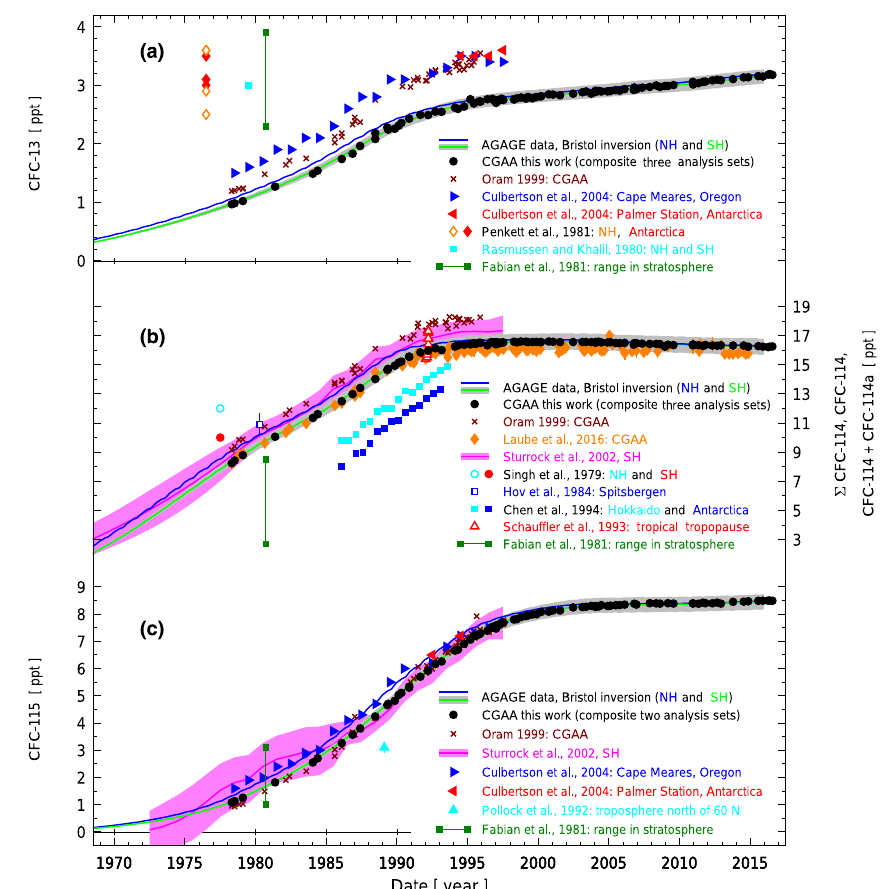
Figure 5. Comparison of the atmospheric records of CFC-13 (a) , (cid:54) CFC-114 (b) , and CFC-115 (c) from this study with previous results. Cape Grim Air Archive (CGAA) samples and subsamples have been analyzed multiple times – here we show analysis results published by Oram (1999), Laube et al. (2016), and the present study (three separate analysis sets are averaged; see Supplement). Light grey bands denote the uncertainty on our SH model results including calibration uncertainty. Uncertainty bands for the NH, which are similar to the SH, are omitted from this plot for clarity. Results for (cid:54) CFC-114 are from combined measurements of the two analytically unseparated C 2 Cl 2 F 4 isomers. Exceptions to this are the studies by Oram (1999) and Laube et al. (2016) in which the numerical sums of the two individual isomer measurements are shown. Also, results by Chen et al. (1994) (values approximated only from their graphical display) are of CFC-114 only. Assuming a 5–6% contribution of CFC-114a in (cid:54) CFC-114, these results are still significantly lower compared to our study. All results are left on the calibration scales of the published